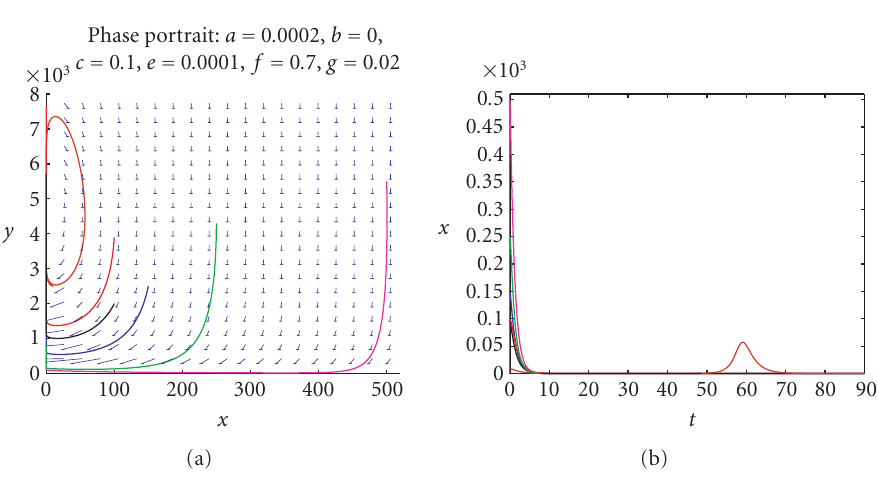
Figure 3.9. Using the same parameters as for Figure 3.3(a) except that e = 0 . 0001, we see a dra- matic drop in the equilibrium population of terrorists through nonviolent intervention (compare with Figure 3.3(a)). The fixed point is now at x 0 ≈ 14, y 0 = 4500.